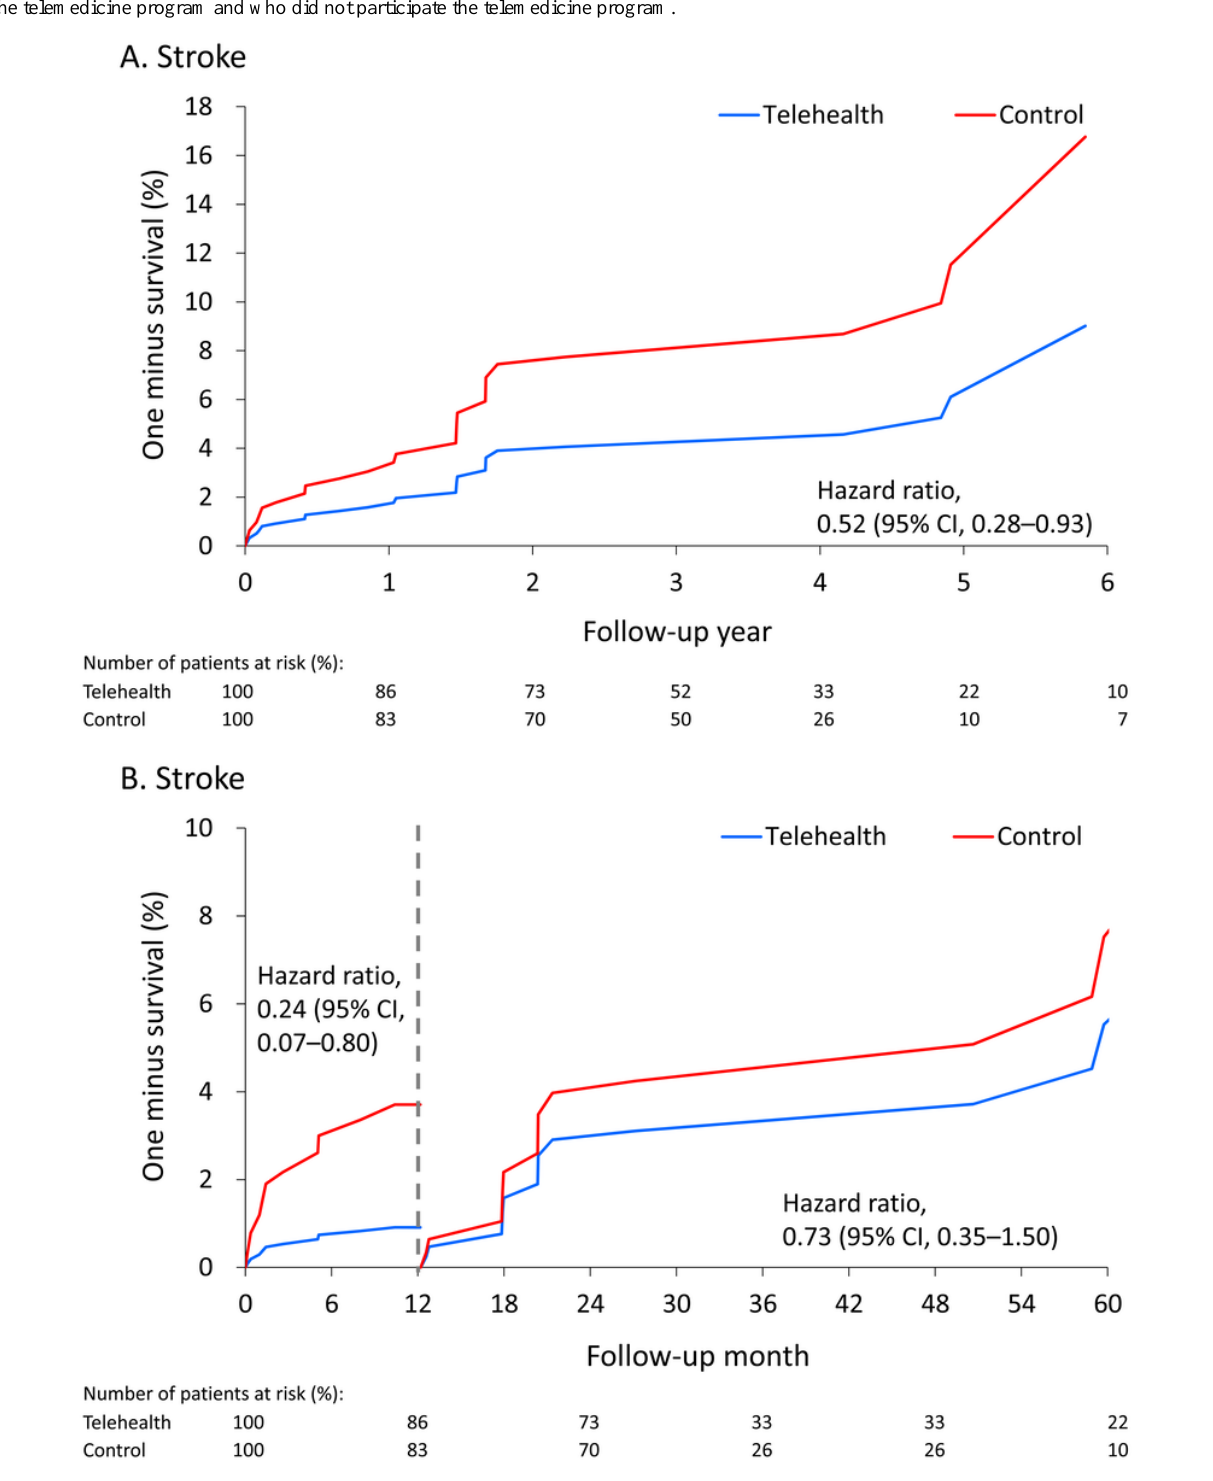
Figure 2. Fitted (predicted) survival curves of stroke during the overall follow-up (A) and stratified by 1-year follow-up (B) in patients who participated in the telemedicine program and who did not participate the telemedicine